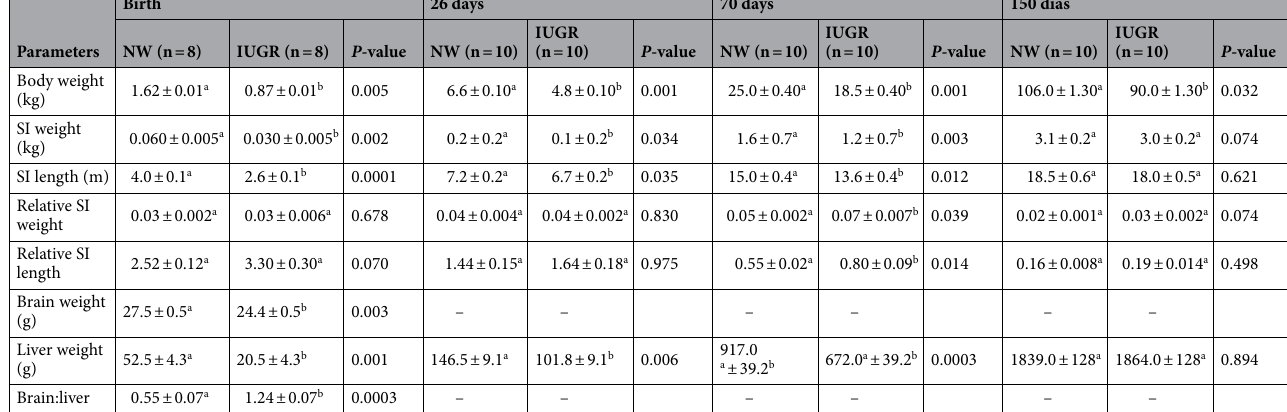
Table 1. Body weight and intestinal biometrical parameters from normal (NW) and intrauterine growth restricted (IUGR) male littermate pigs throughout the production phases. Relative SI weight: small intestine (kg)/body weight (kg). Relative SI length: small intestine (m)/body weight (kg). SI small intestine. ab Within the same age, least square means with different superscripts within a row differ (P < 0.05).